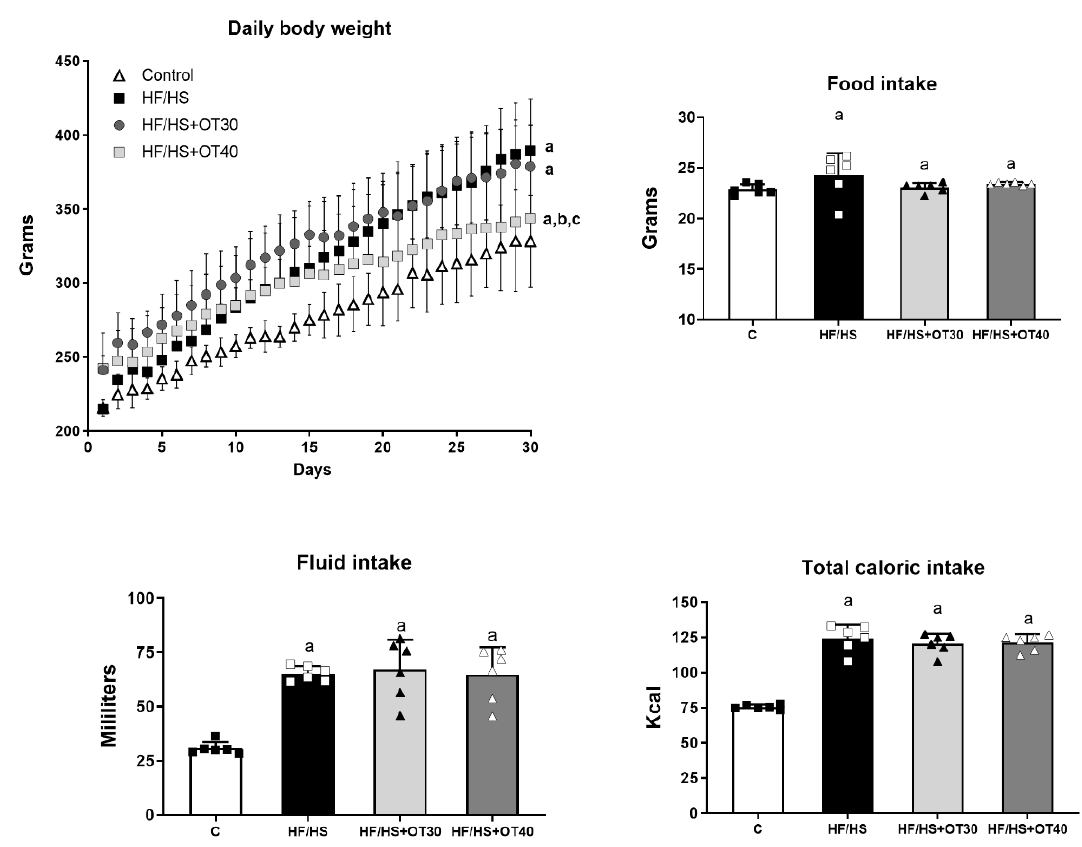
Figure 1. Effects of high-fat/high-sugar (HF/HS) diet and osthol administration on body weight, total intake of food, fluids, and calories. Results are presented as te mean ± SD and analyzed by one-way ANOVA. Post hoc analysis was performed using Bonferroni ’s test. a: p < 0.05 vs. control.